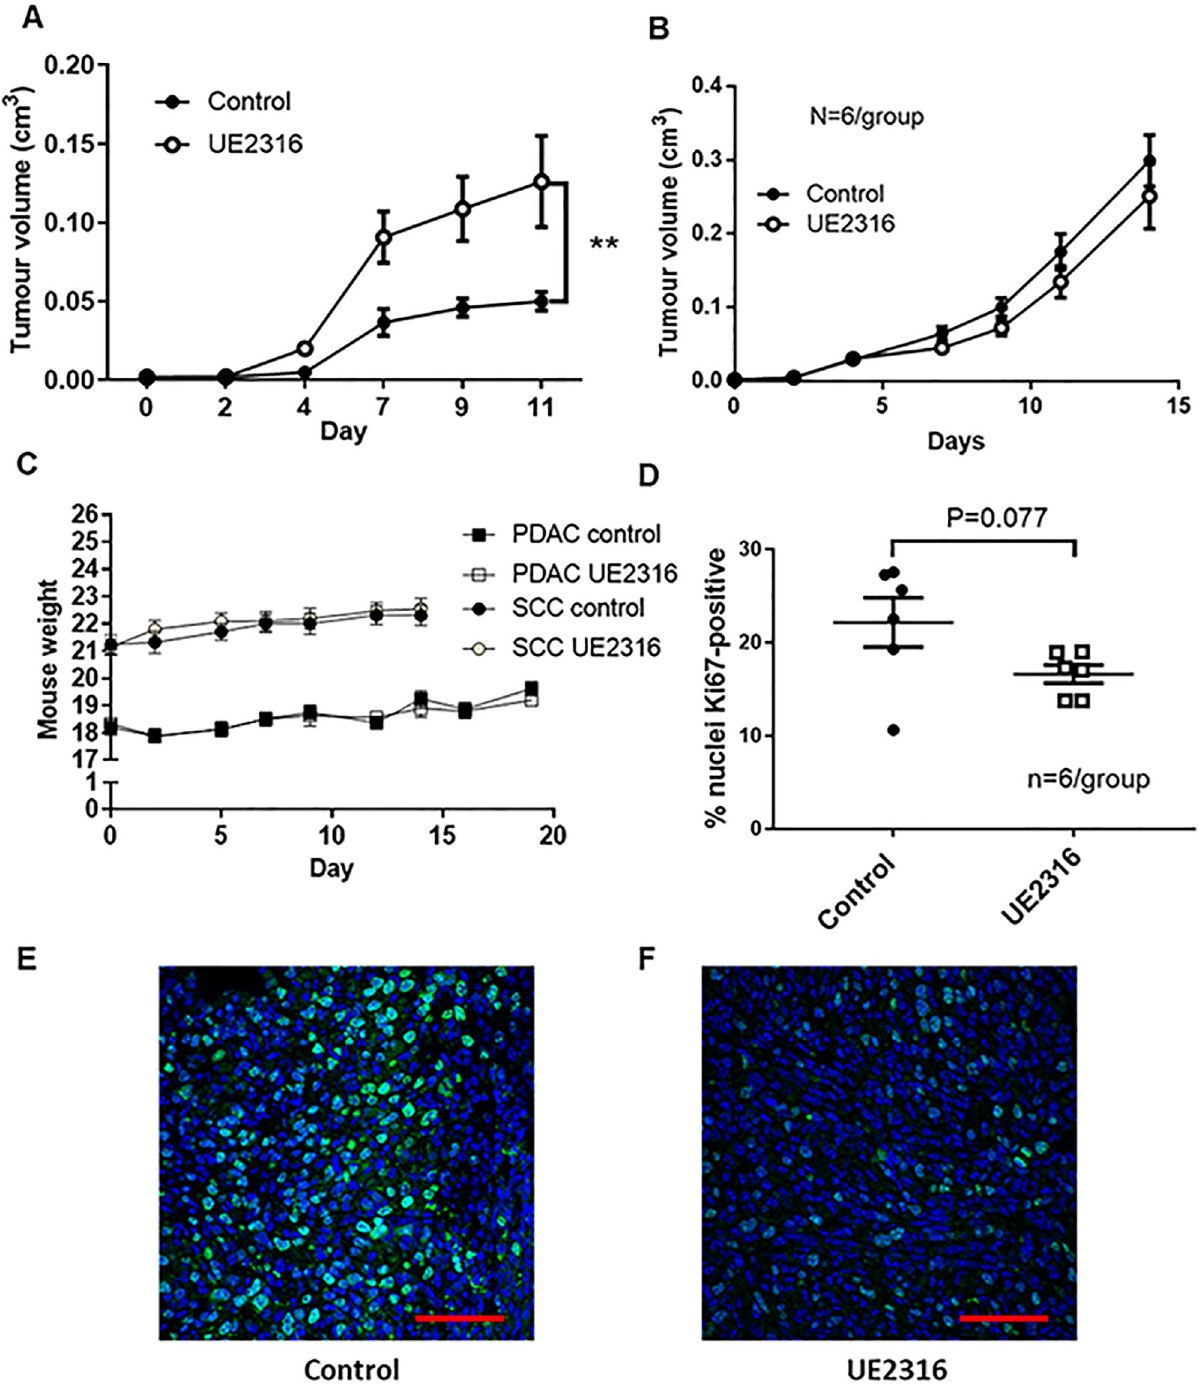
Fig 2. The 11 β -HSD1 inhibitor UE2316 enhances SCC but not PDAC tumour growth. A) UE2316 enhanced tumour growth from day 4 onwards in mice injected with SCC cells. N = 9/group. B) UE2316 did not affect PDAC tumour growth in mice injected with Panc043 cells. N = 6/group. C) Neither tumour cell injection (day 5) nor UE2316 diet introduction affected mouse weight. N = 6-9/group. �� P < 0.01. Data were compared by 2-Way ANOVA. D) The proportion of cells staining positive for proliferation marker Ki67 showed a trend towards being reduced (P = 0.07) in tumours from UE2316-treated mice but this did not reach significance. N = 6/group. Data were compared by independent samples t-test. Representative images of hotspots from Ki67-stained squamous cell carcinoma (SCC) tumours from control (E) and UE2316 treated (F) mice are shown. Hotspots were typically near the periphery of the tumour. Scale bar = 50 μ